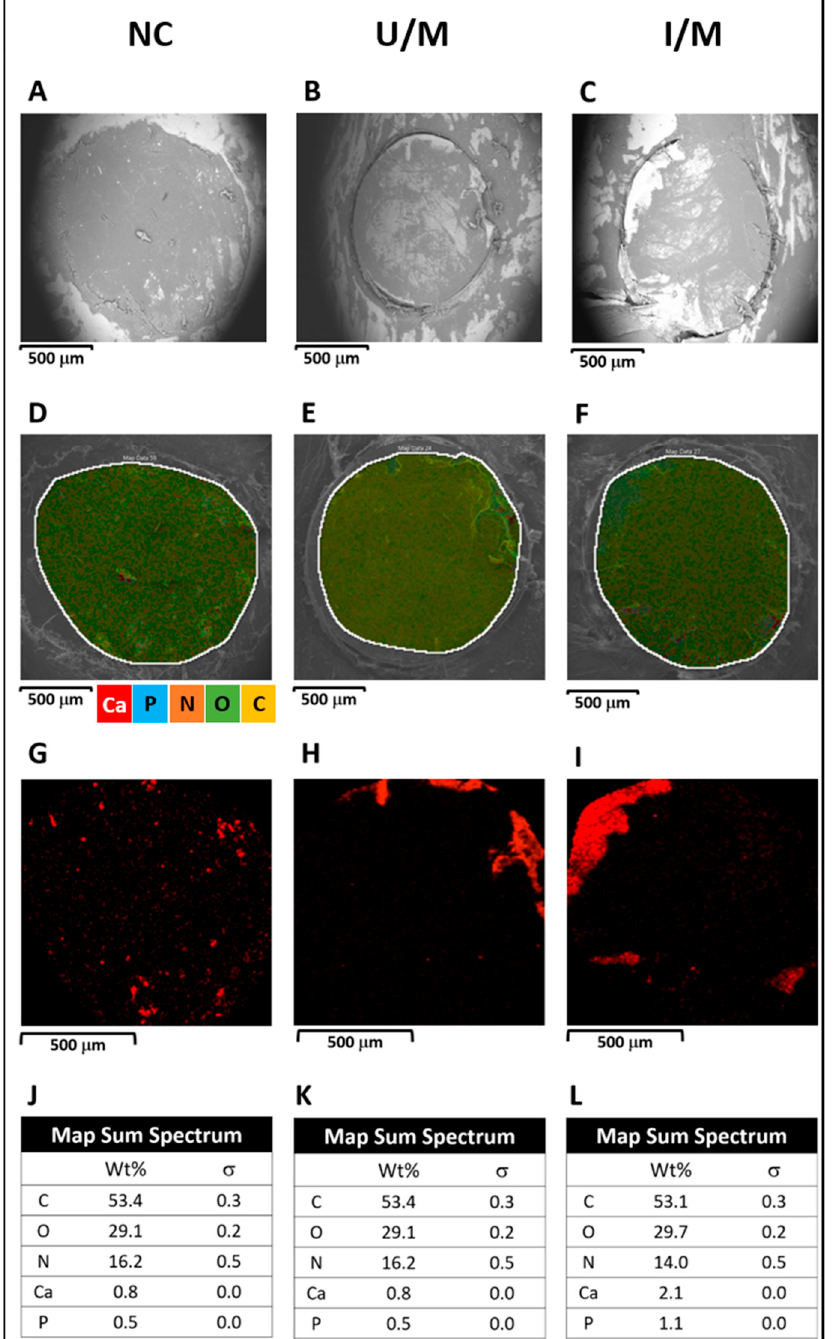
Figure 5. BS-SEM images ( A – C ), multi-element EDX mapping ( D – F ), calcium EDX mapping ( G – I ), and EDX element contents ( J – L ). Each images columns corresponds to: NC (negative control, un- treated calvarial defect), U/M: membrane non-UV-irradiated and I/M: membranes UV-irradiated .